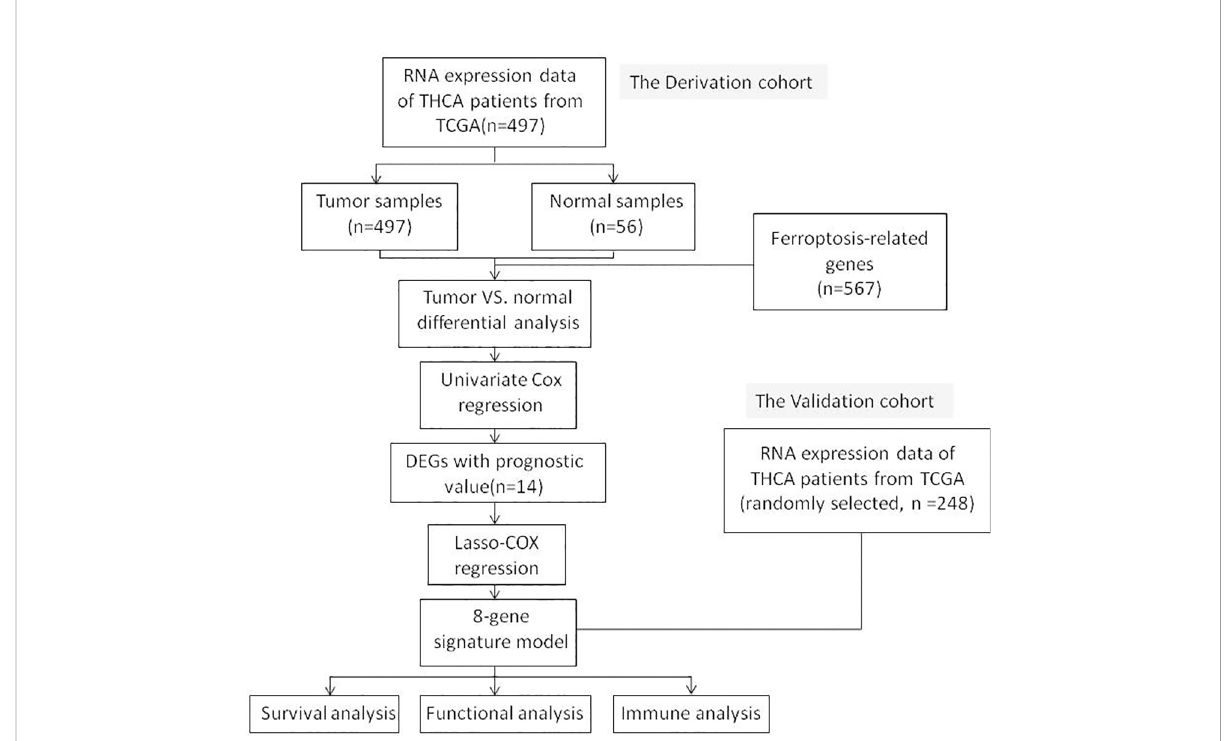
FIGURE 1 A fl owchart depicting the construction and validation of data collection and